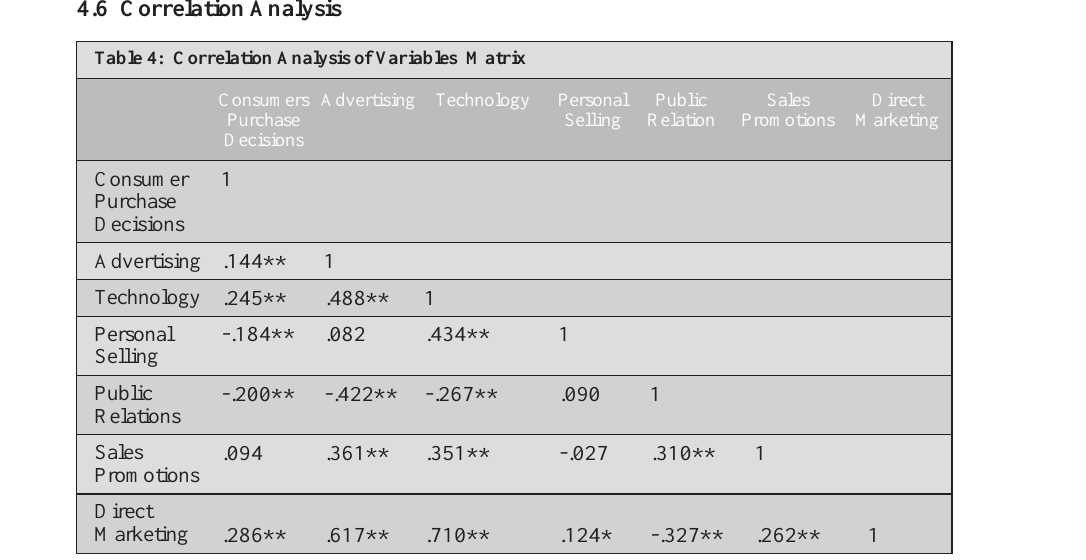
Table 4: Correlation Analysis of Variables